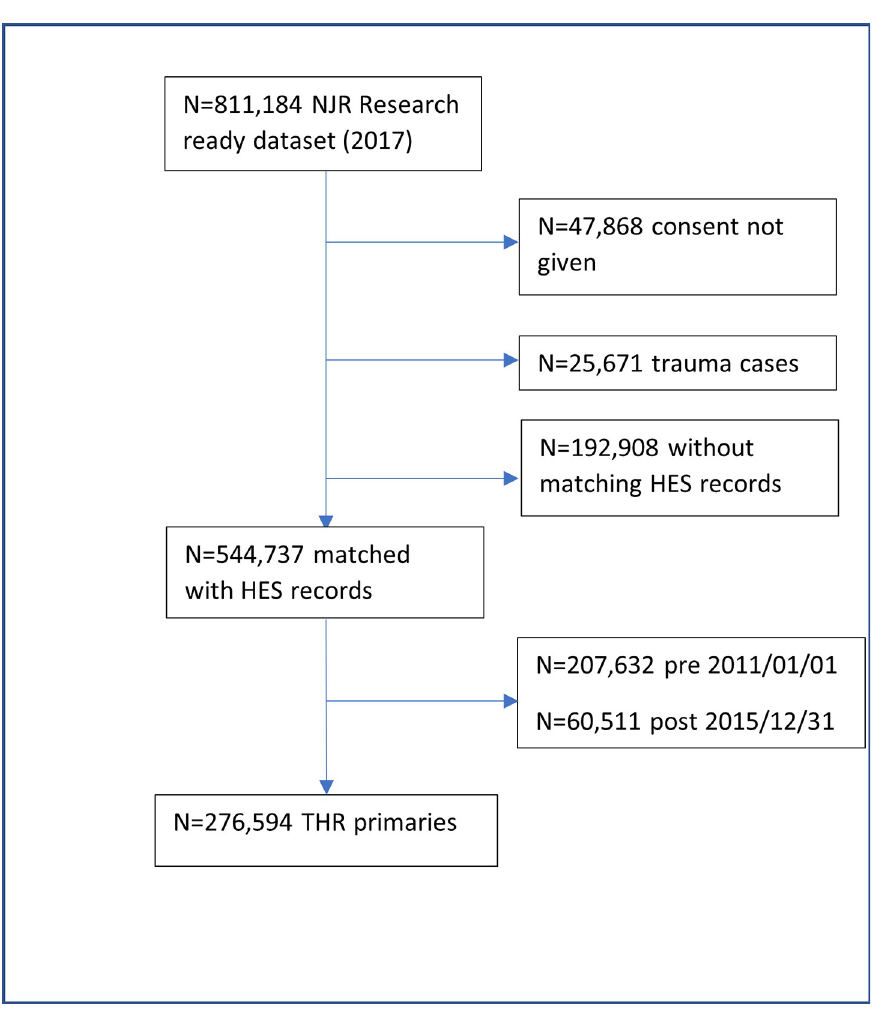
Fig 1. Flowchart of eligible primary